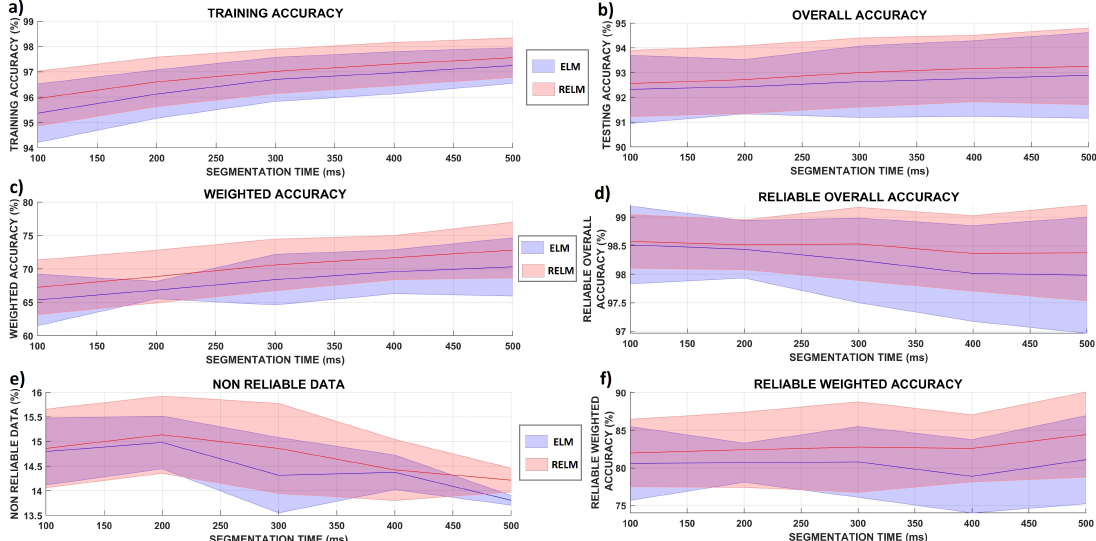
Figure 8. Influence of segmentation lengths in different metrics of the system: Notably, the standard versions of the classifiers tend to benefit slightly from more extensive lengths for feature extraction, while this does not affect the reliable form of the classifiers